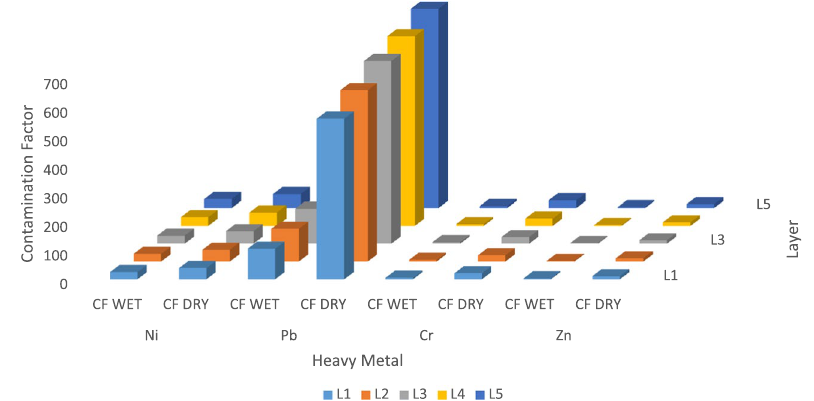
Figure 9. Contamination Assessment through Contamination Factor for the Lithofacies.